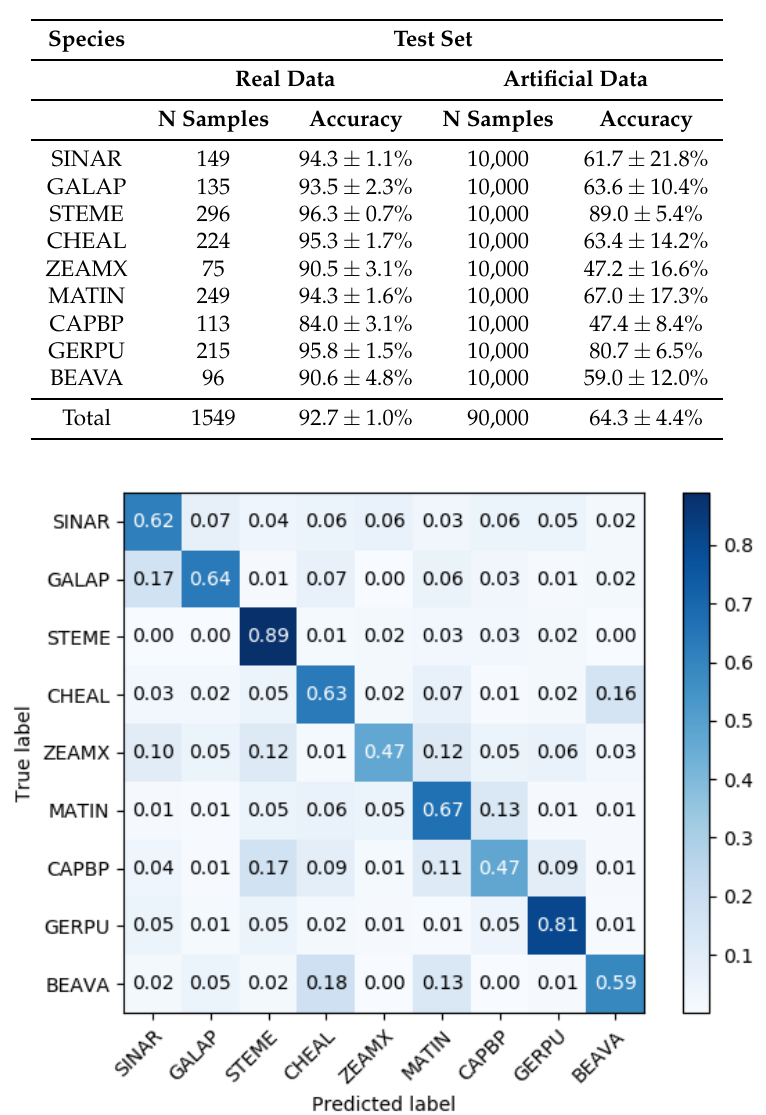
Table 3. The accuracy of recognizing the intended species of the artificial samples from WacGAN-info, when analyzed using an external ResNet101 classifier trained solely on real data samples from sPSD. The recognition accuracies are reported as the mean and standard deviation over the six combinations in the cross-validation scheme.